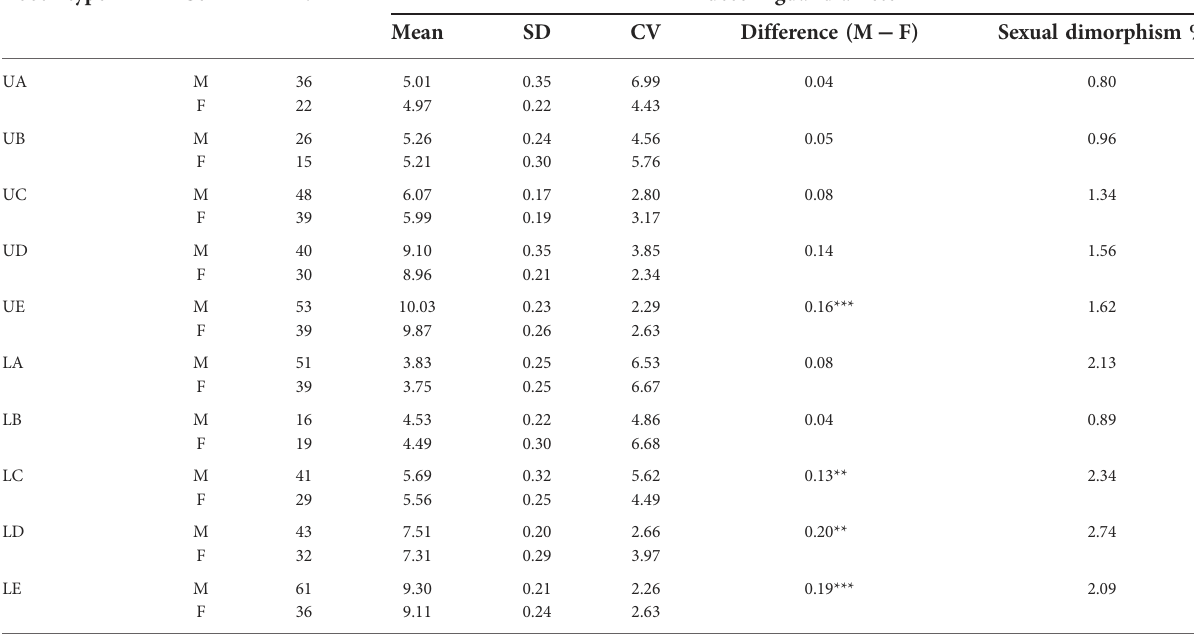
TABLE 5 Buccolingual diameter (mm) and sexual dimorphism of the total sample.